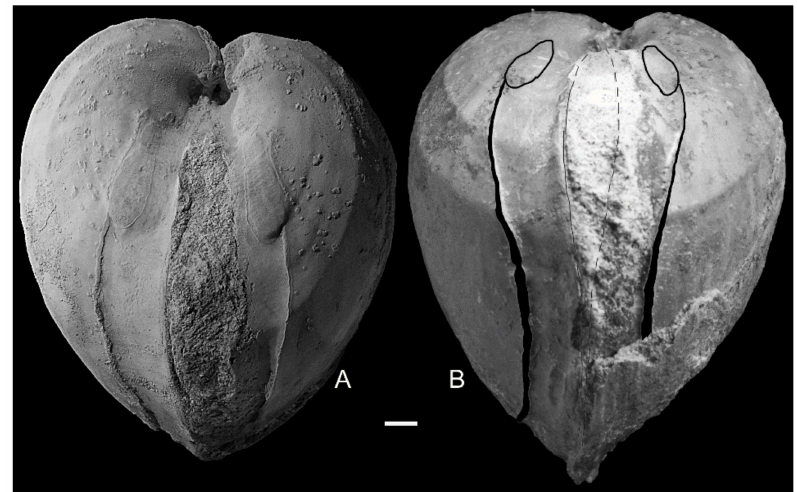
Figure 11. Imprints of anterior adductors and anterior parts of mantle muscles. Anterior ( A ) and antero-ventral ( B ) views of Pholadomya protei , Callovian, Bol˛ecin, Polish Jura (specimen MGUS.Sz.3921, ( A ), whitened with ammonium chloride, ( B ), with marked anatomical